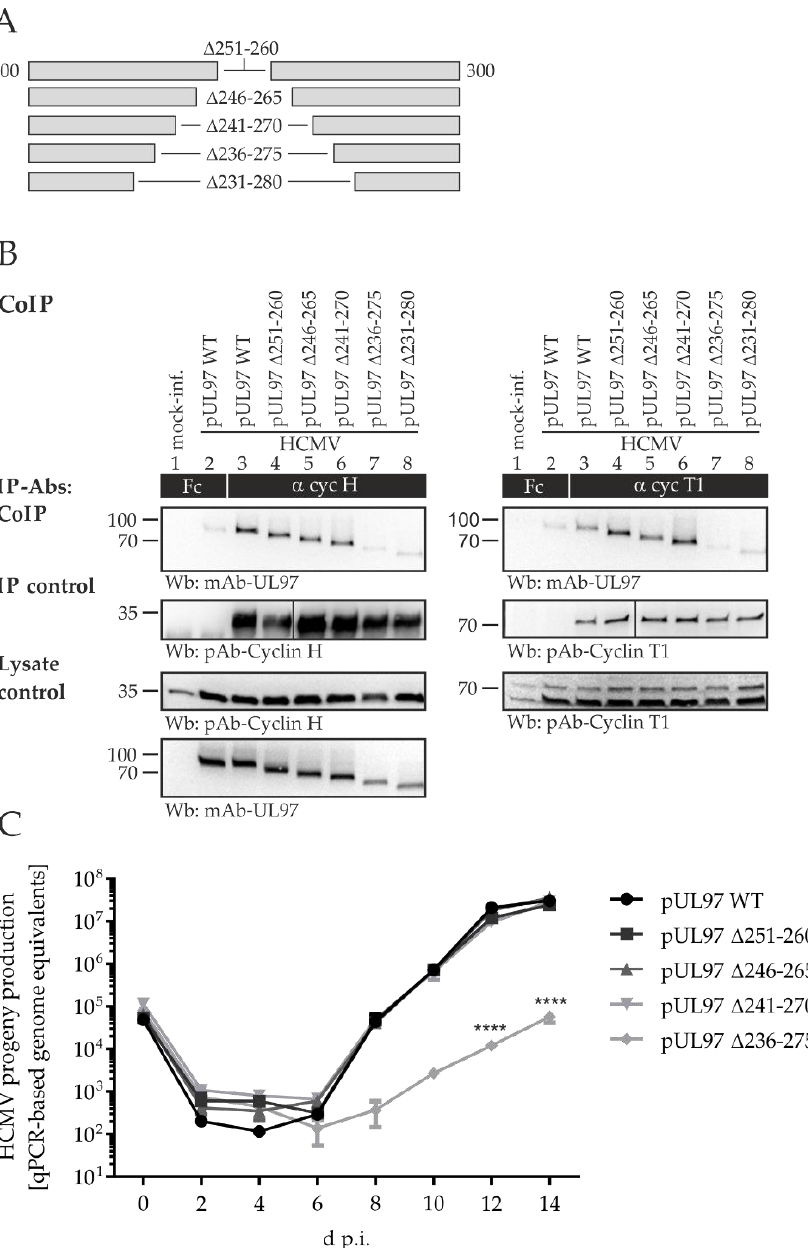
Figure 6. Interaction analysis with human cyclins, and viral replication kinetics of HCMV ORF-UL97 deletion mutants within the amino acid region 231-280. ( A ) A schematic depiction of newly generated HCMV ORF-UL97 deletion mutants in fragments of amino acids 231-280. ( B ) HFFs in T175 flasks were infected with HCMV AD169 WT, ORF-UL97 mutant versions, or remained mock-infected. Cells were harvested and lysed 4 d.p.i. Lysate control samples were taken before human cyclins H and T1 were immunoprecipitated using the specific antibodies indicated. A chicken Fc fragment served as negative control. All samples were subjected to Wb analysis, and proteins were detected using specific monoclonal and polyclonal antibodies as indicated below the panels. ( C ) A total of 225,000 HFFs in 12-well plates were infected with parental HCMV strain AD169-GFP WT or ORF-UL97 deletion mutants at a viral dose of 1 × 10 5 genome copies. Viral supernatants were harvested at indicated time points and viral genome equivalents were determined by qPCR. Each value represents the mean ± SD of two independent biological replicates, each measured twice. Statistical analysis was performed using an ordinary two-way ANOVA and post-hoc Sidak correction; ****, p <